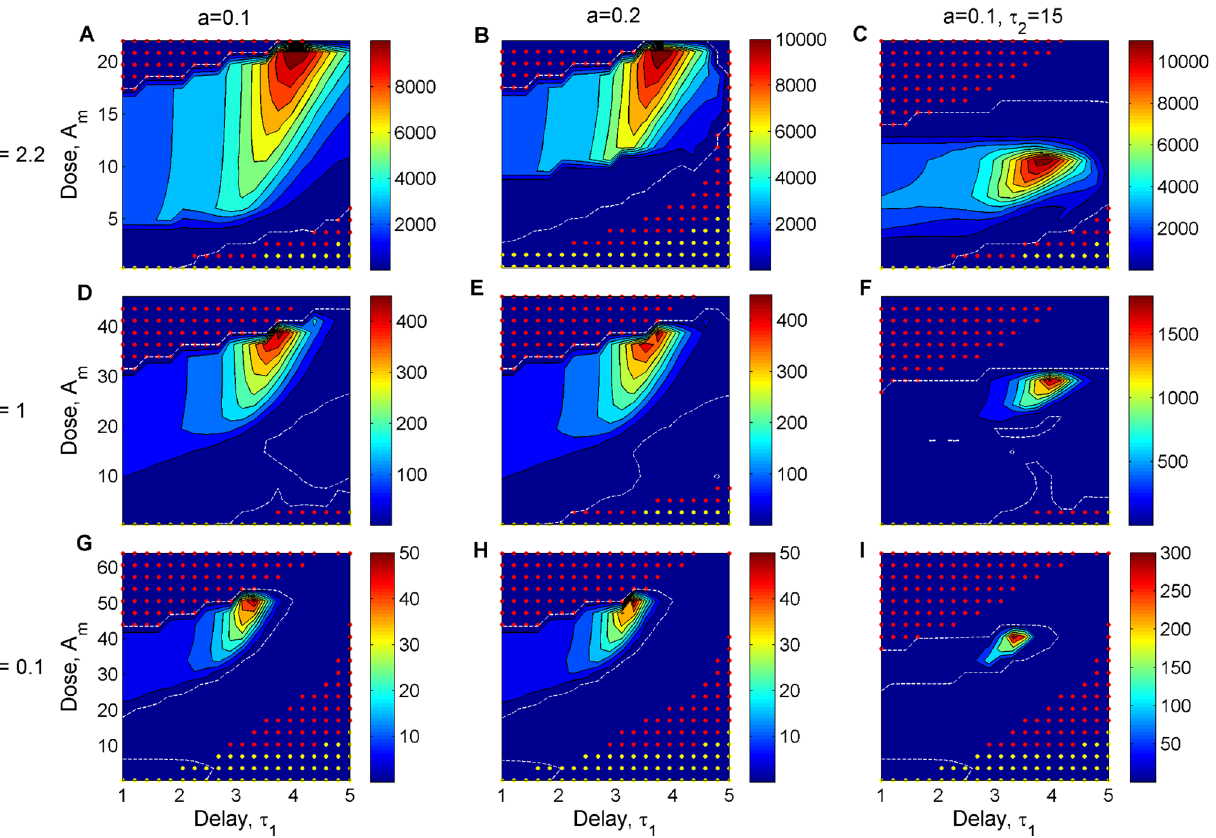
Fig 5. Resistance selection over treated infections, for different combinations of dose A m and delay τ 1 in the classical regime. The simulated values ; 2 A (cid:6)(cid:6) (cid:8) . We plot the proportional change in the resistance burden over treated infection R of A m correspond to 30 doses in the range ½ 0 : 1 A (cid:6) tot , relative to the m m same measure in untreated infection, as a function of antibiotic dose and timing of treatment onset for a range of infection scenarios. In the subpanels, the bene fi t and cost of resistance, and treatment duration vary as: A) a = 0.1, c = 2.2, τ 2 = 7; B) a = 0.2, c = 2.2, τ 2 = 7; C) a = 0.1, c = 2.2, τ 2 = 15; D) a = 0.1, c = 1, τ τ τ τ τ τ 2 = 7; E) a = 0.2, c = 1, 2 = 7; F) a = 0.1, c = 1, 2 = 15; G) a = 0.1, c = 0.1, 2 = 7; H) a = 0.2, c = 0.1, 2 = 7; I) a = 0.1, c = 0.1, 2 = 15. The resistance selection window is de fi ned by the dashed white line (contour line corresponding to a proportional change of 1). Superimposed are treatment combinations that maintain infection duration within a factor of 1.1 relative to no treatment (yellow dots), and those that, in addition, satisfy a reduction in immunopathology by at least 2-logs order of magnitude (red dots). All parameters as in Table 1, unless otherwise stated. The growth rate of the resistant bacteria B r is varied as r 1 = r 0 − c (different rows). Moderate dose-delay combinations, applied below the resistance selection window at each infection, can be effective in clearing the pathogen, in synergy with host immune responses. The aggressive high doses instead are effective without relying on the contribution by the immune